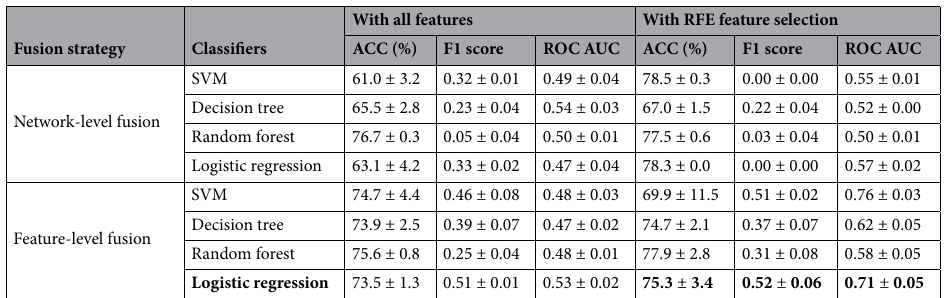
Table 3. Results of linear classifiers on SEQC dataset. Significant values are in bold.